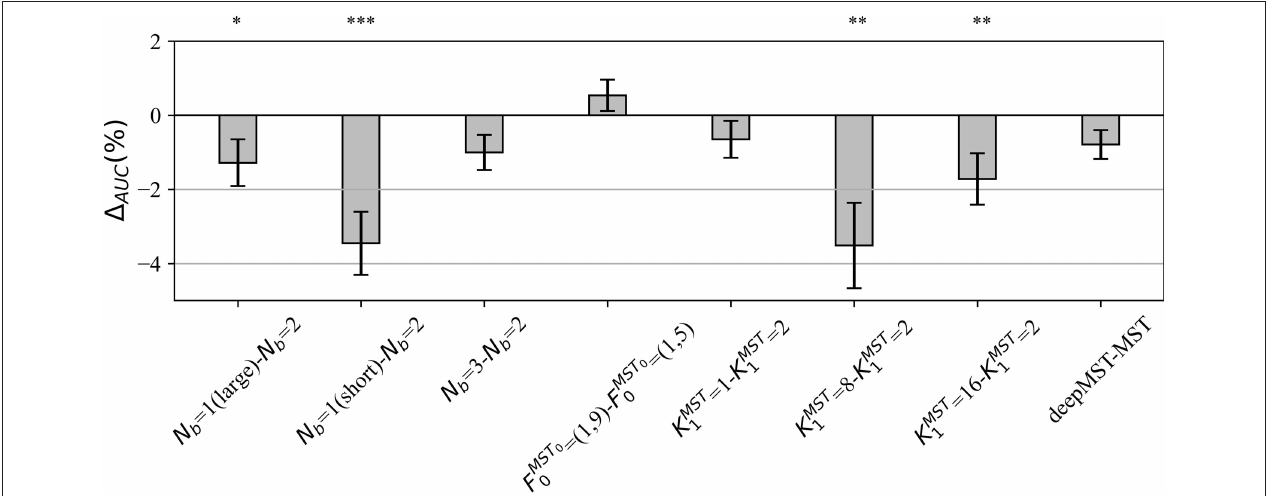
FIGURE 2 | Impact of alternative design choices of MS-EEGNet on the performance metric. The figure reports the difference between the AUC scored with the variant and the baseline design (i.e., 1 AUC = AUC variant − AUC baseline ) for each condition of the hyper-parameter ( HP ) tested, reported on the x-axis as “ HP variant − HP baseline . ” The height of each gray bar represents the mean value across the participants of 1 AUC , while the error bar (black lines) represents the standard error of the mean. The results of Wilcoxon signed-rank tests (see section Statistics-ii) are also reported (* p < 0.05, ** p < 0.01, *** p < 0.001, corrected for multiple tests) on top of the